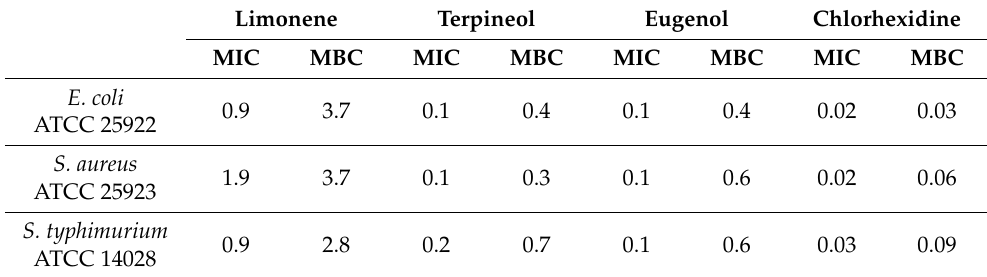
Table 1. MIC and MBC of limonene, terpineol, eugenol and chlorhexidine against E. coli , S. aureus and S. typhimurium . Limonene Terpineol Eugenol Chlorhexidine MIC MBC MIC MBC MBC